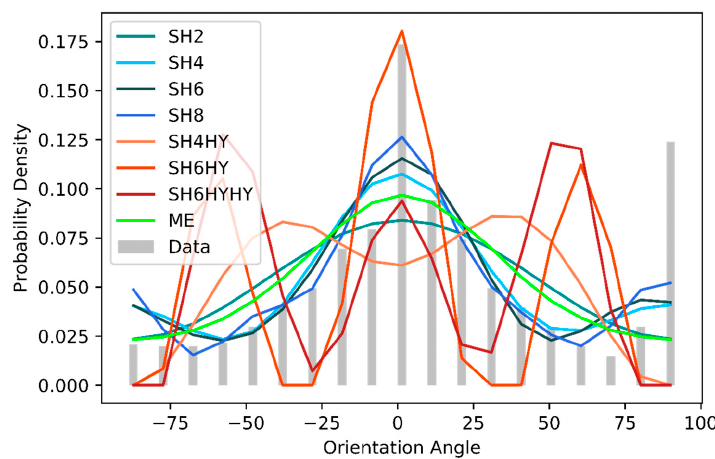
Figure 13. Measured and reconstructed ODFs from [43].